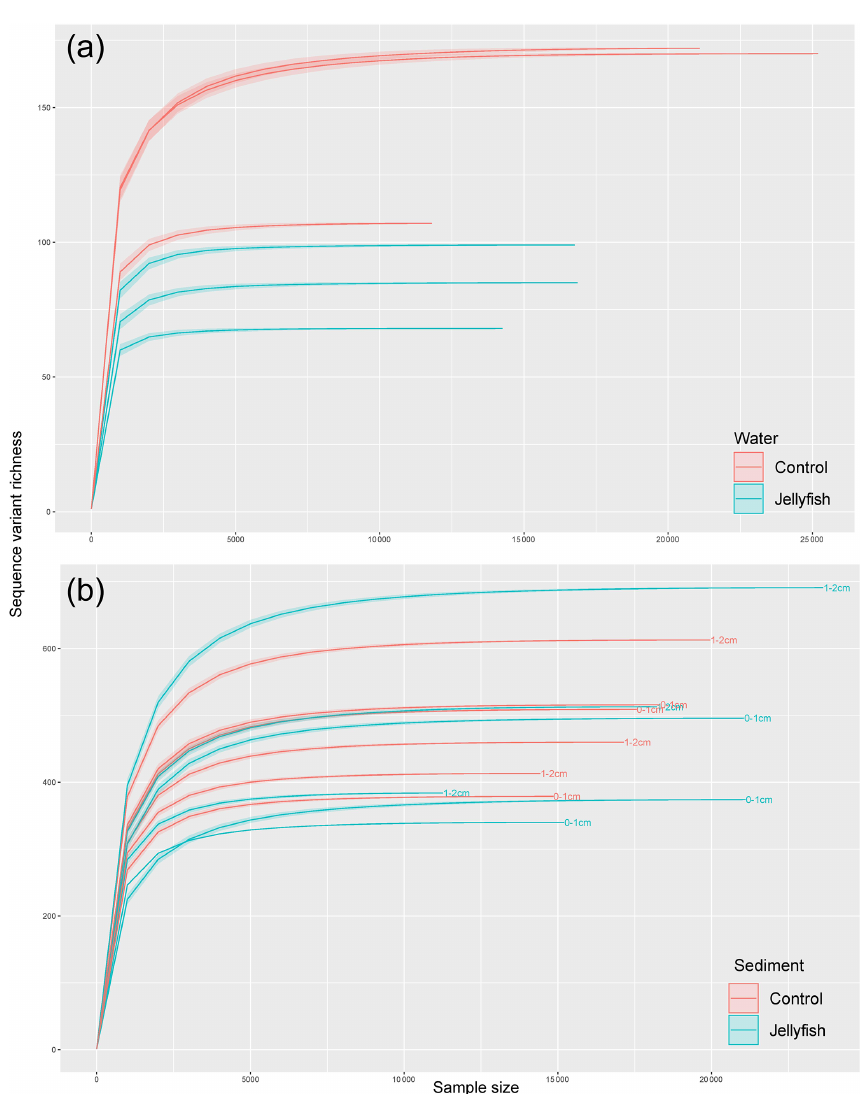
Figure C3. Rarefaction curves of observed 16S rRNA sequence variants retrieved from the seawater (a) and sediment (b)